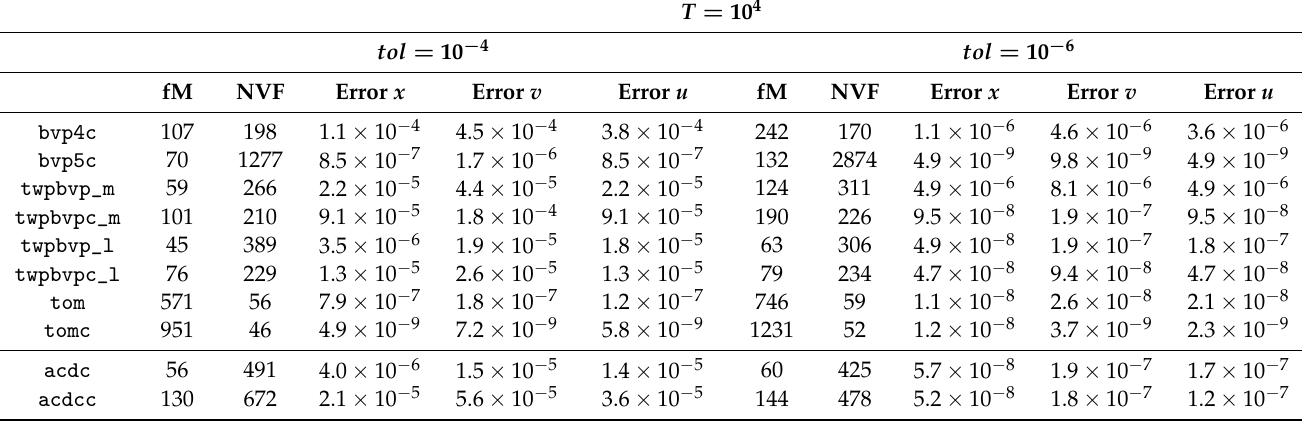
Table 9. Hypersensitive problem using the variable τ = t / T , initial mesh with 11 equidistant points and continuation strategy on T : final mesh (fM), total number of vectorized function evaluation (NVF) and mixed errors for x , v , u . T = 10